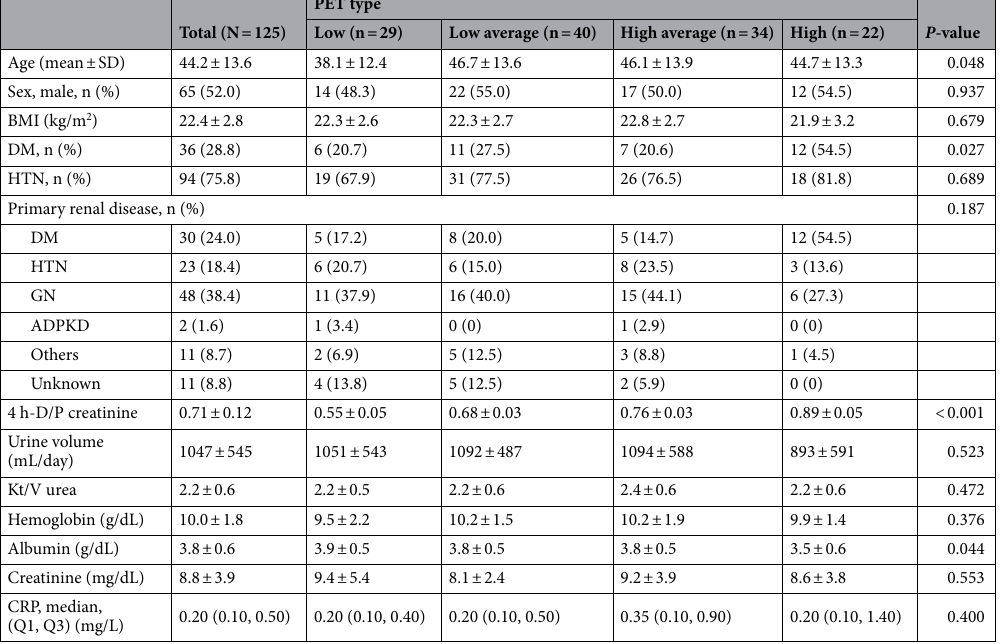
Table 1. Demographic characteristics according to the PET types. PET peritoneal equilibration test, BMI body mass index, DM diabetes mellitus, HTN hypertension, GN glomerulonephritis, ADPKD autosomal dominant